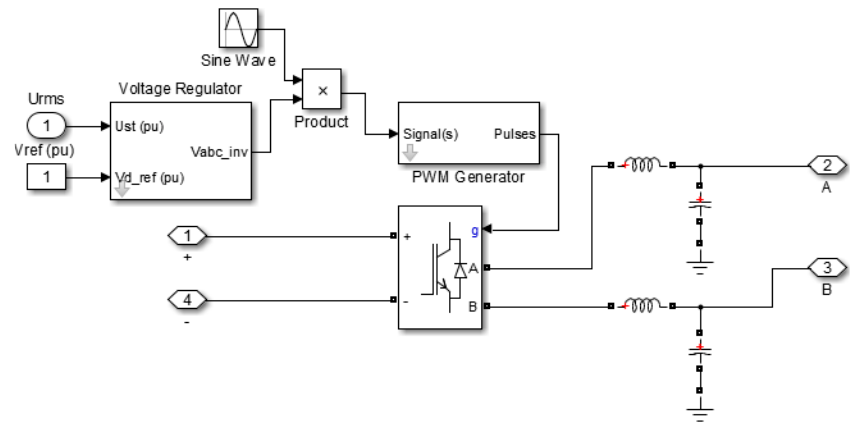
Figure 3. Schematic of the inverter control